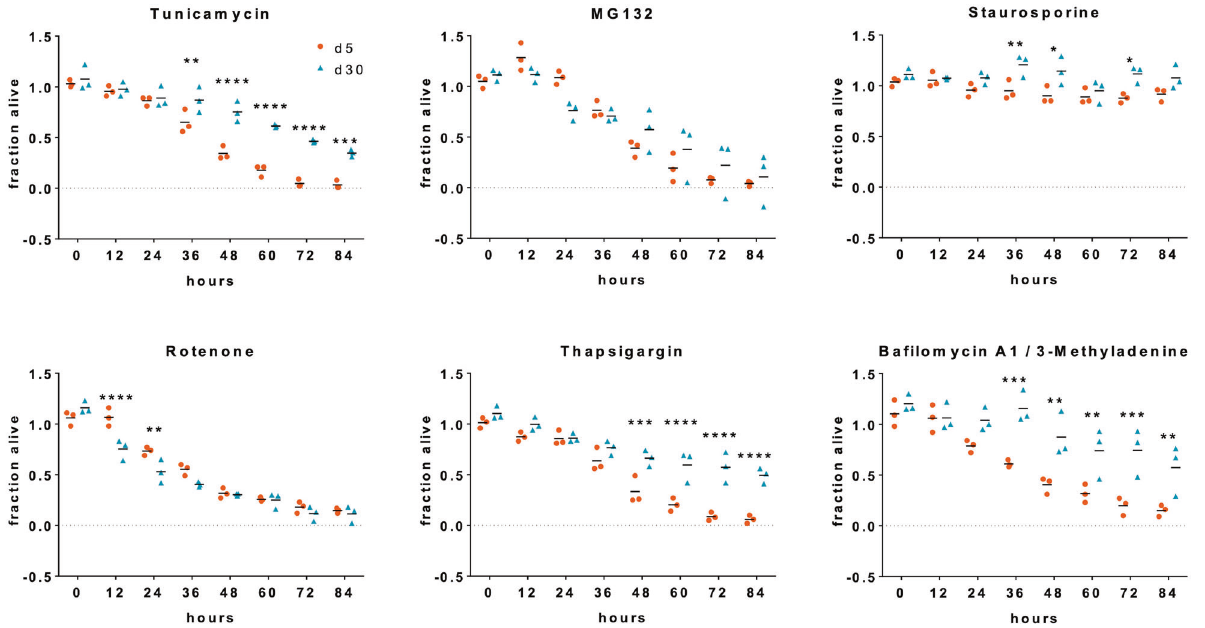
respective DMSO-treated control cells. Bar graphs show means of three independent experiments (performed in hexuplicates) and mean of the 3 experiments, two-way ANOVA with Bonferroni